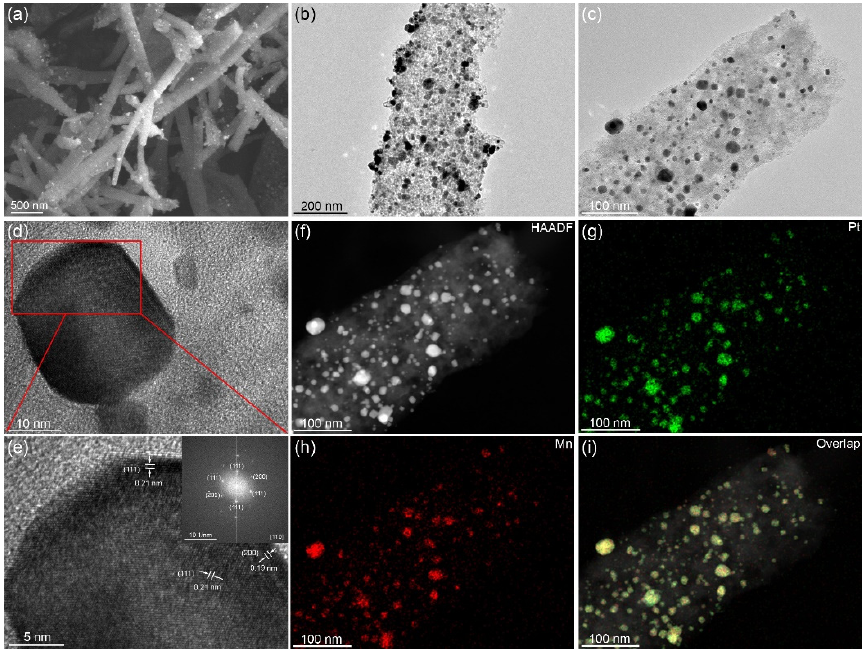
Figure 3. ( a ) SEM and ( b , c ) TEM images of PtMn ‐ 950/CNFs. ( d , e ) HRTEM image of a random PtMn nanoparticle for PtMn ‐ 950/CNFs. ( f – i ) High ‐ angle annular dark ‐ field scanning transmission electron microscope (HADDF ‐ STEM) image and element (Pt and Mn) mappings for PtMn ‐